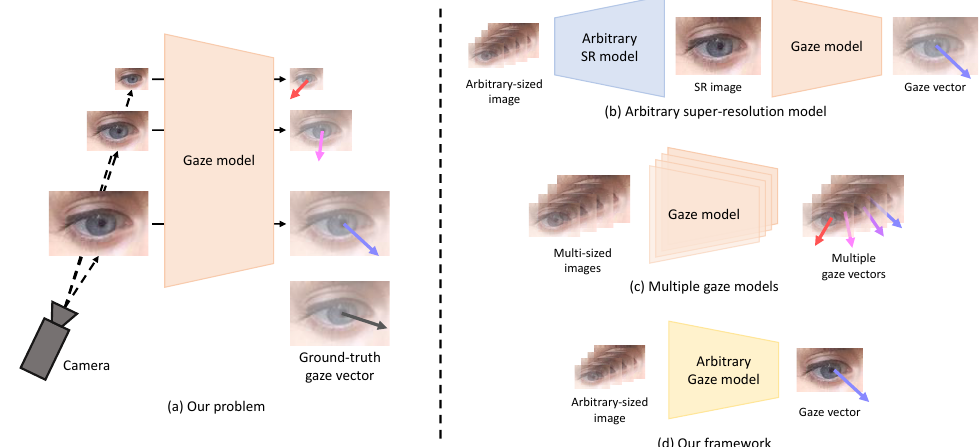
Figure 1. The problem to be addressed in this study (i.e., gaze estimation from arbitrary-sized low-resolution images) is shown in ( a ). Low-resolution images of various sizes can degrade the gaze estimation performance of the existing gaze estimation model. The following approaches can be used to solve this problem: ( b ) a method based on an arbitrary SR model, ( c ) a method based on several different gaze estimation models corresponding to various resolutions, and ( d ) the proposed method that is based on a single